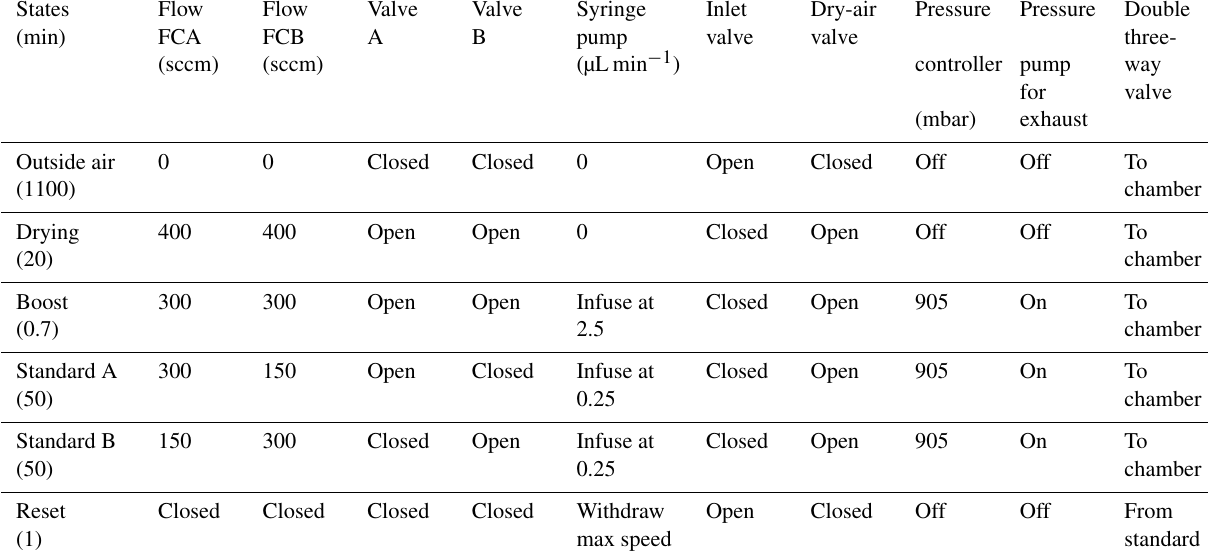
Figure 3. Allan deviation over 4h for different humidity levels (black, 1080ppmv; dark blue, 770ppmv; green, 400ppmv; pink, 320ppmv; yellow and light blue, 170ppmv) for humidity (a) , δ 18 O (b) and δ D (c) . Table 1. Typical routine sequence of measurements and calibration for two standards A and B at 1000ppmv for a measurement site located at sea level. No mixing occurs between standards A and B during steps “Standard A” and “Standard B” (see Supplement). Note that the humidity-isotopes mode and the expert mode can also be included in the valve sequencer but are not used in a daily calibration routine.